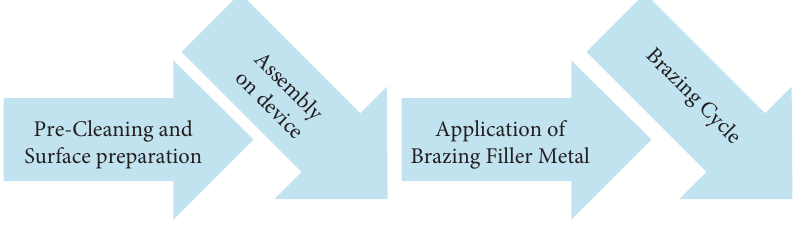
Figure 4. Brazing